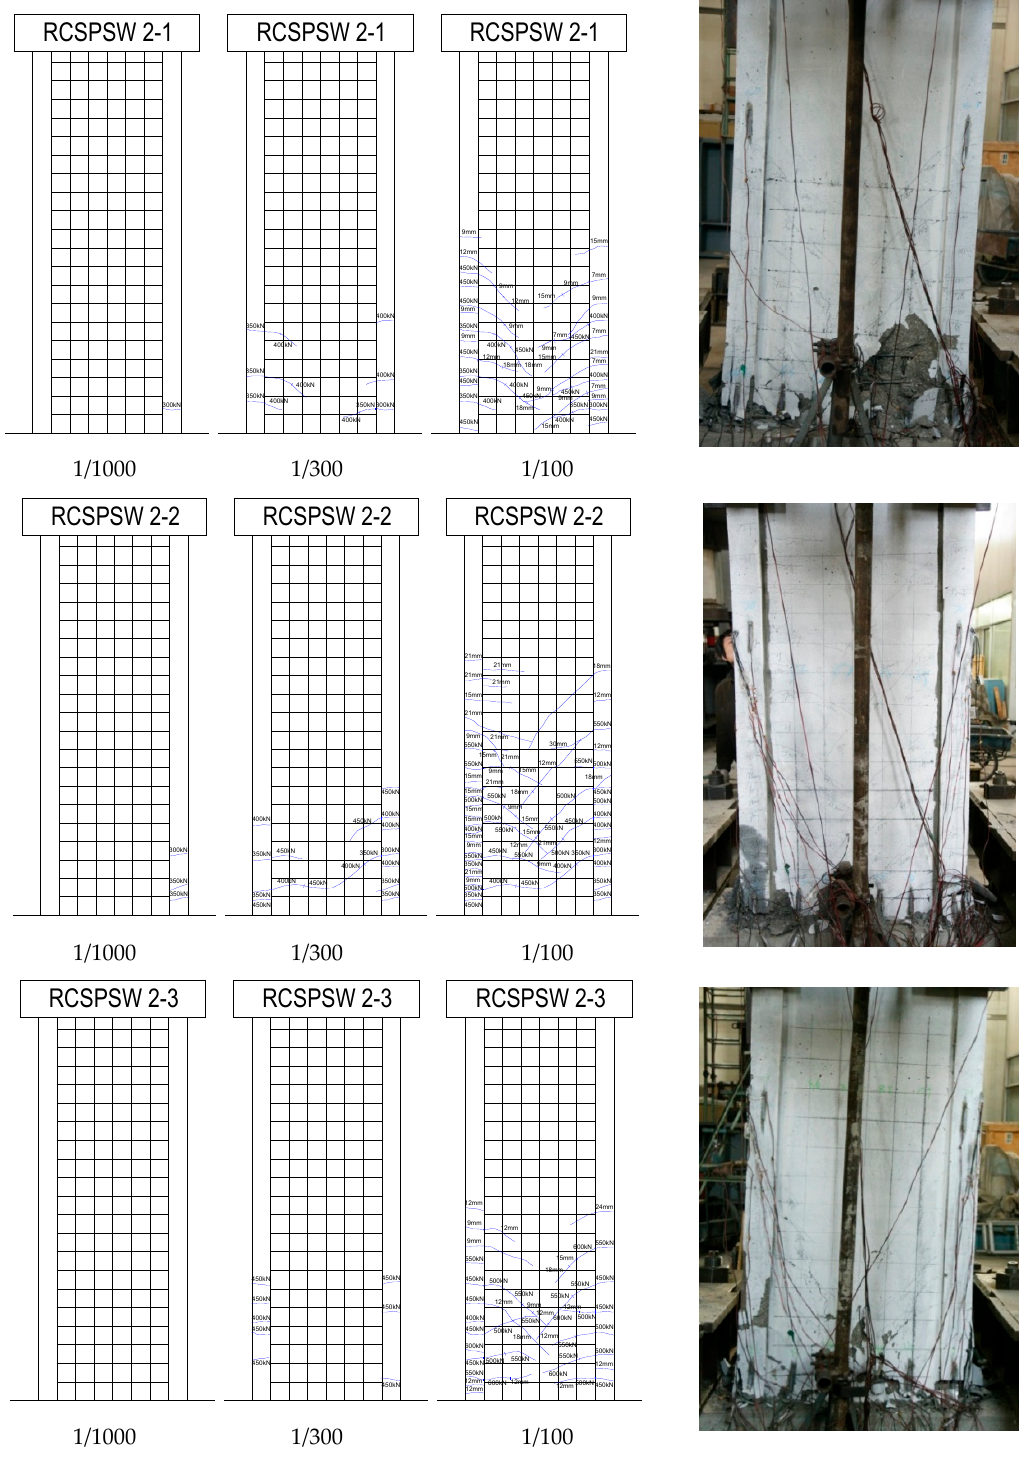
( a ) Crack Distribution at Different Inter-story Drifts ( b ) Failure Pattern Figure 8. Crack Distributions and Failure Patterns of Specimens with Aspect Ratio of 2.7 ( a ) Crack Distributions at Different Drifts and (b) Photograph of Failure Patterns (Continued).